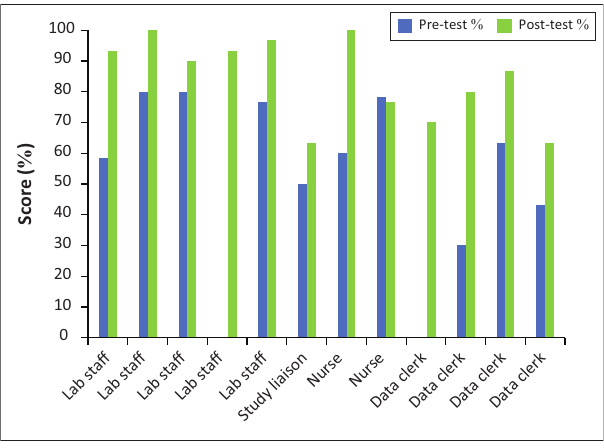
FIGURE 3: Partnership to empower Project B’s clinical site in Nigeria. I-HAB engaged clinical sites through needs assessment, training and mentorship, pilot exercise, and continuous monitoring in preparation for sample deposition.